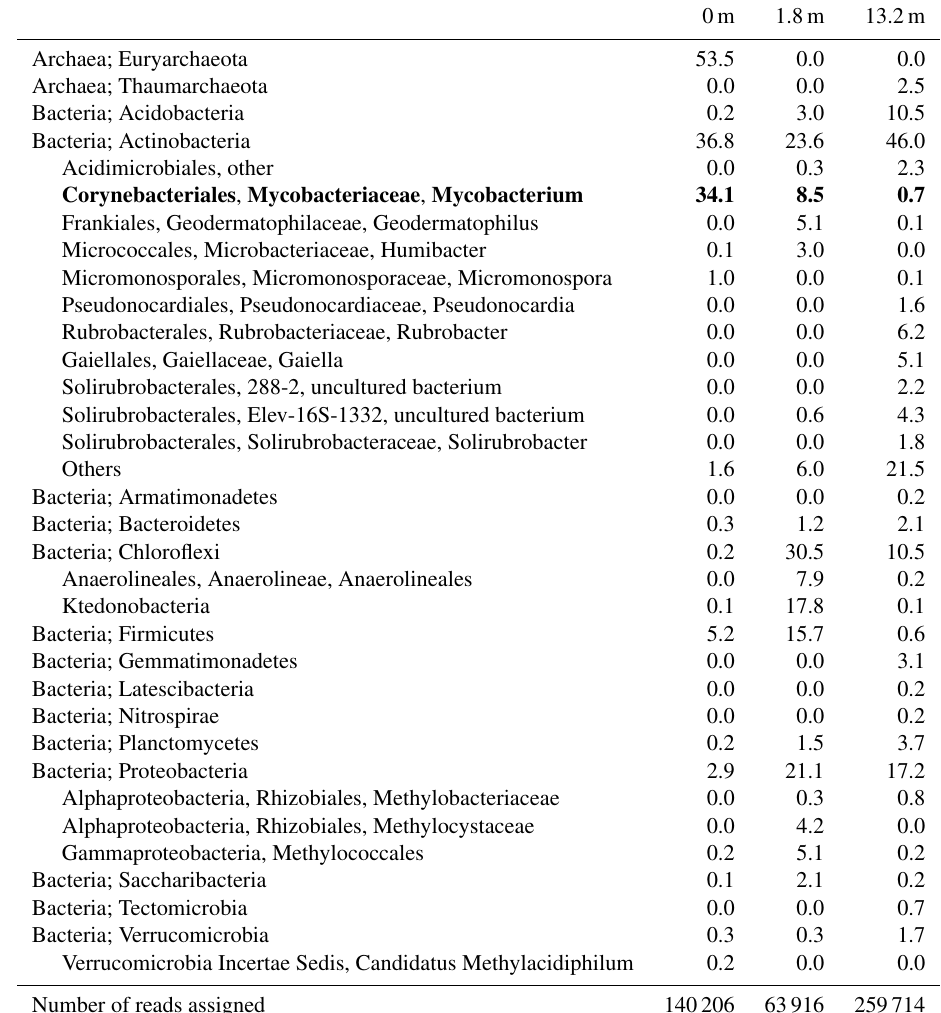
Table 1. Distribution of the main microbial groups (in percentage of assigned reads) based on 16S rRNA gene amplicon sequencing at three distances from the main gas seep in the Censo soils. The bold typeface annotates the relative abundances of mycobacteria in the Censo